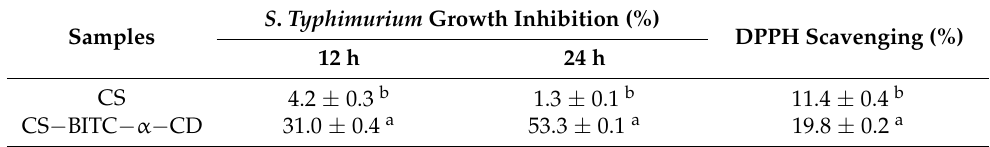
Table 2. Antibacterial and antioxidant capacities of CS and CS − based composite films.